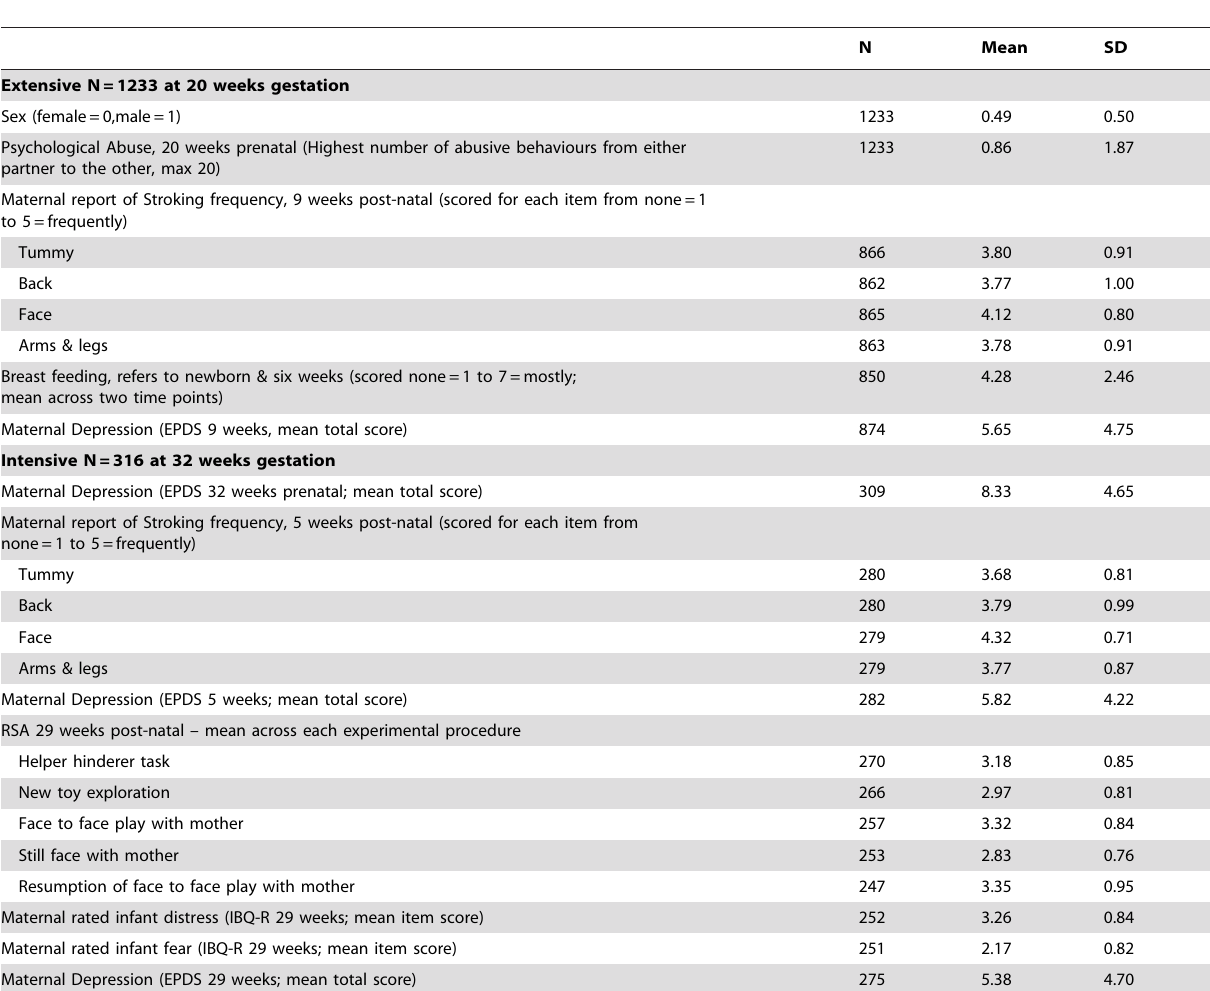
Table 1. Summary statistics of key